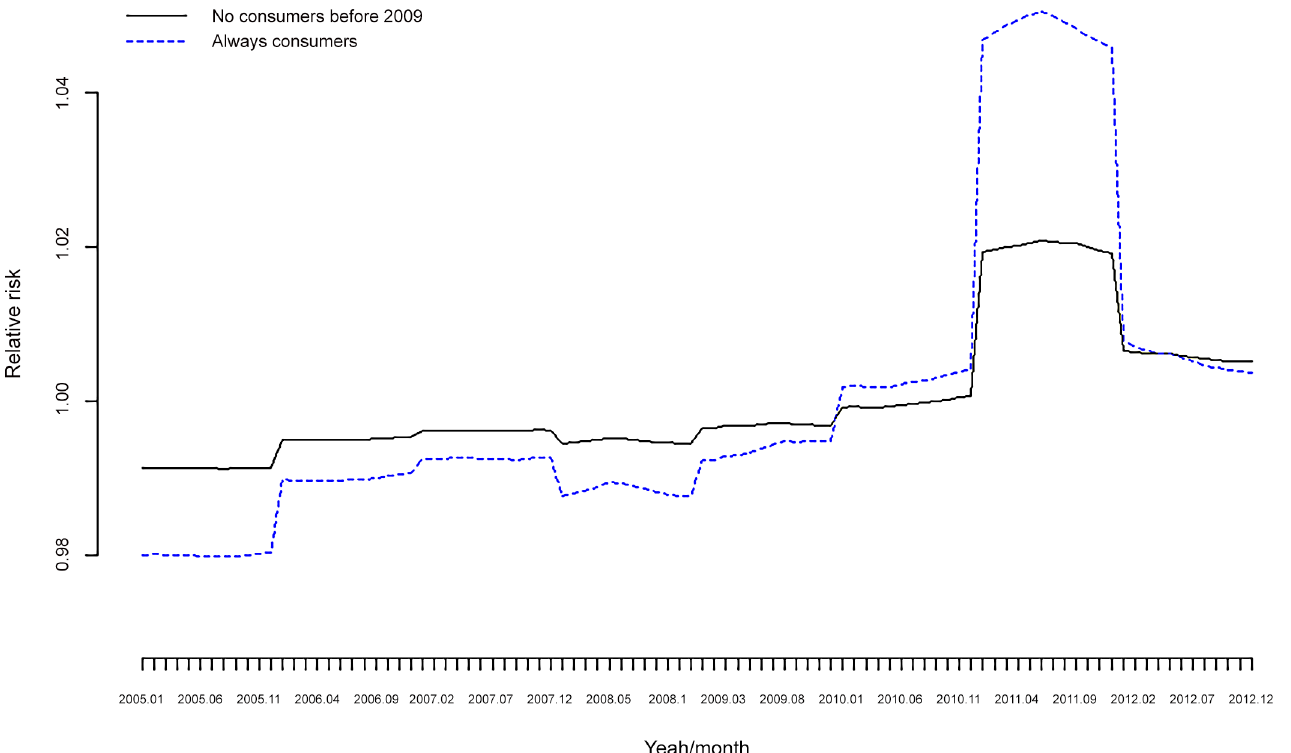
Fig 7. Number of drugs per person/month. Not consumers before 2009 vs. Always